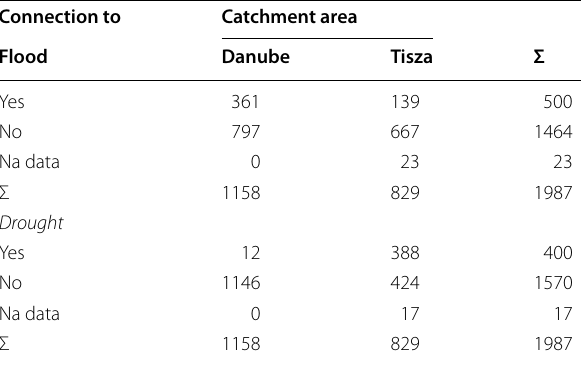
Table 9 Crack appearance connection to flood and drought